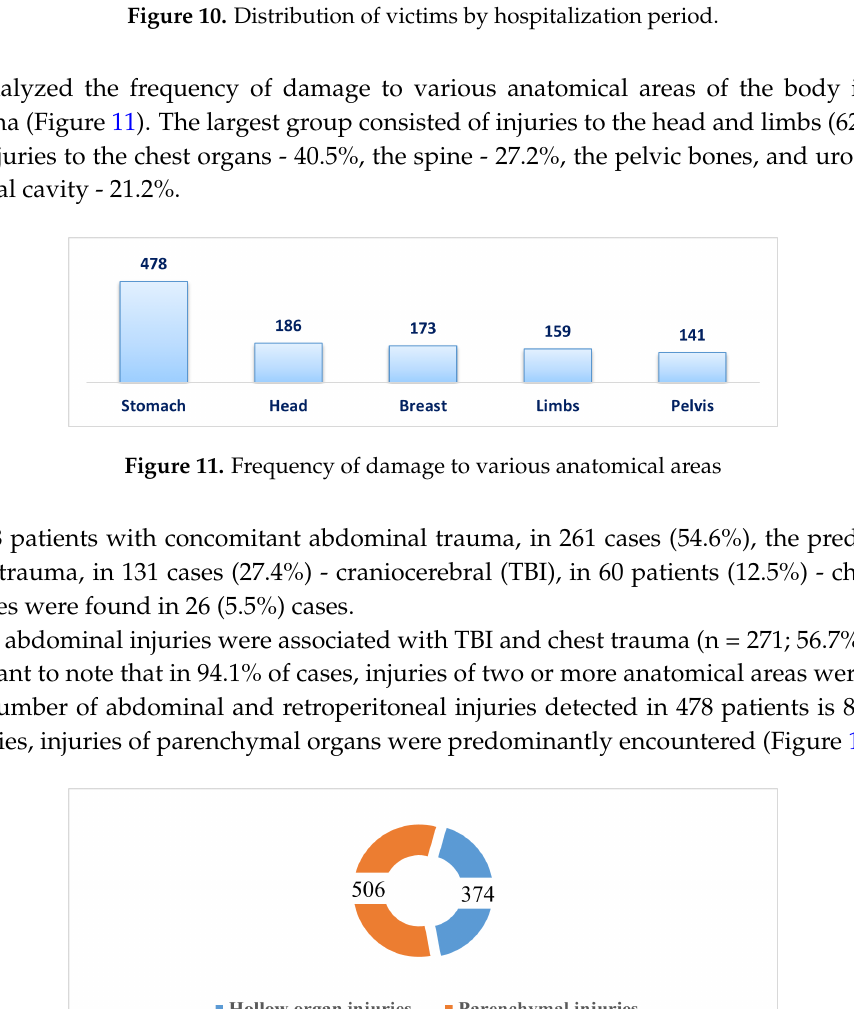
Figure 10. Distribution of victims by hospitalization period.